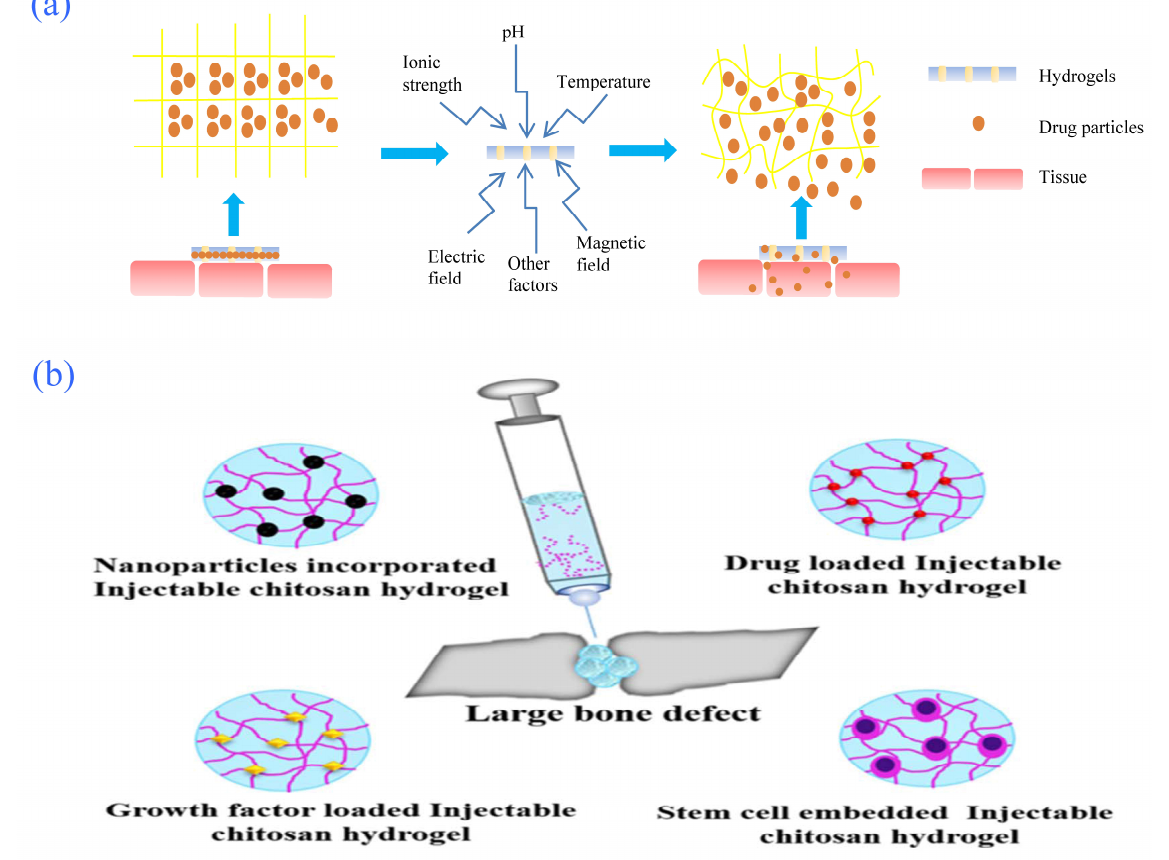
Figure 5. Response mechanism of intelligent hydrogel and its application in promoting bone growth. ( a ) Response process of intelligent hydrogel. ( b ) Thermo/pH-responsive CS hydrogels as delivery carriers for bioactive molecules, NPs, drugs, and cells at the defective site, enhancing bone growth. Reprinted with permission from Ref. [72]. Copyright 2020, Lavanya, K.